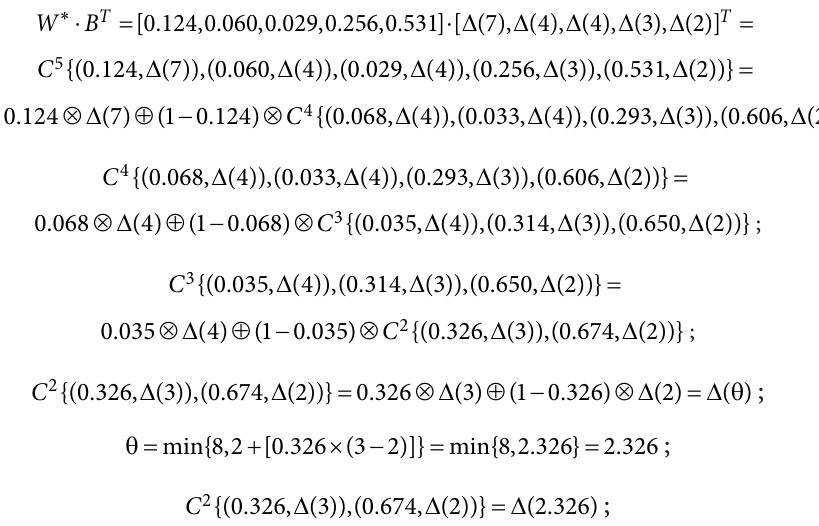
Table 4. Aggregation results for the relationship matrix with the order of priority Scheme Power Graphics & Need Subsystem TV Tuner Sustaining power 7 ( ,0)